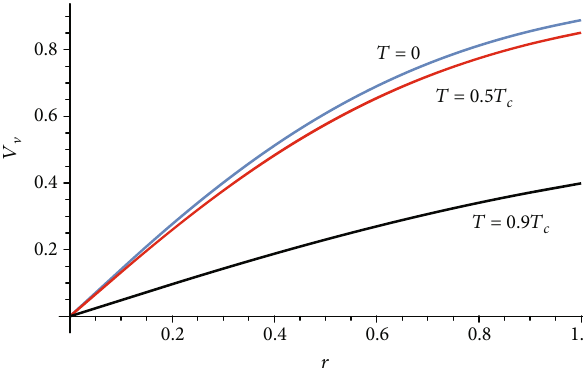
Figure 7: A graph of vector potential V speci fi c values of T . / g with A